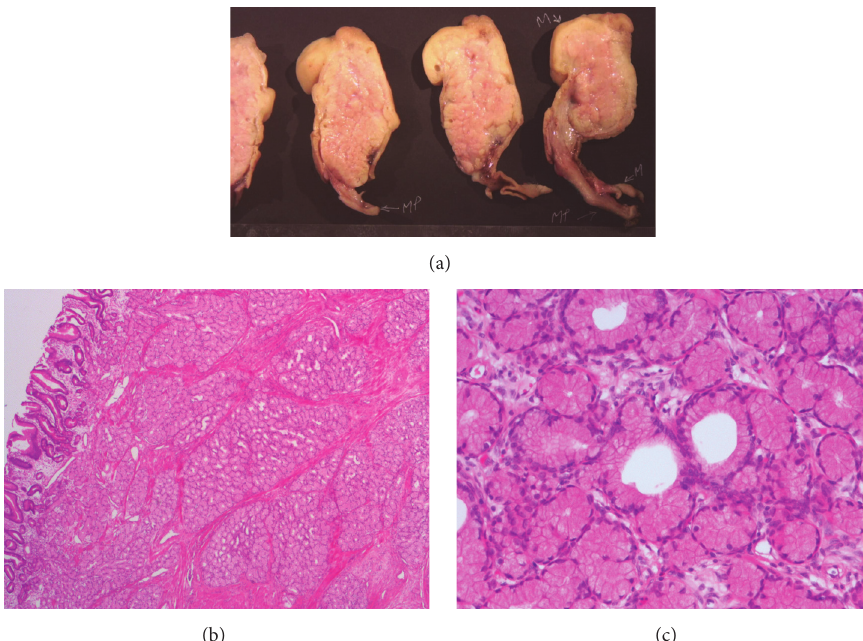
Figure 3: Histopathological examination. (a) 8 × 4 × 8cm submucosal polypoid tumor in the proximal duodenum. ((b) and (c)) Microscopic examination showed extensive proliferation of Brunner’s